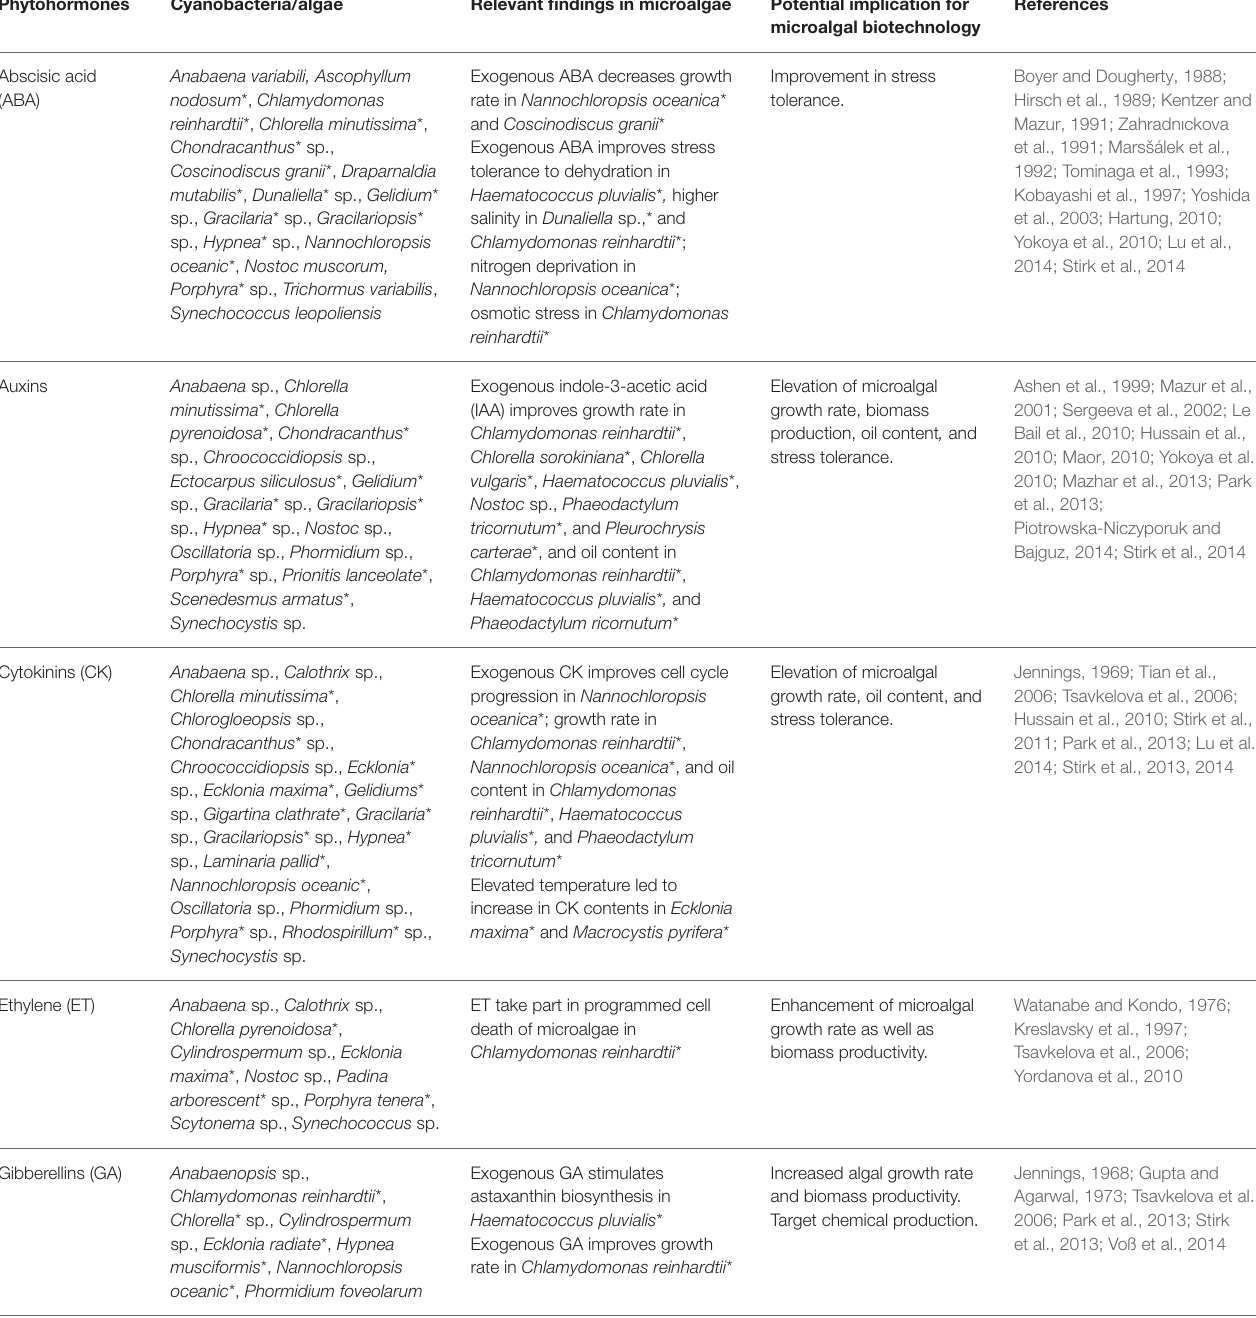
TABLE 2 | An overview of various phytohormones produced by algae and their potential implication in microbial biotechnology.